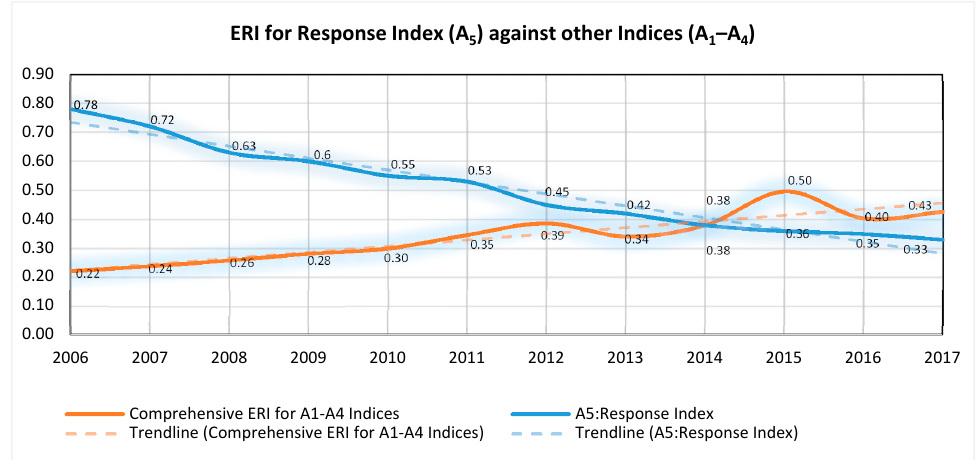
Figure 8 . ERI for Response Index (A 5 ) against other Indices (A 1 –A 4 ) for. Figure 8. ERI for Response Index (A 5 ) against other Indices (A 1 –A 4 )